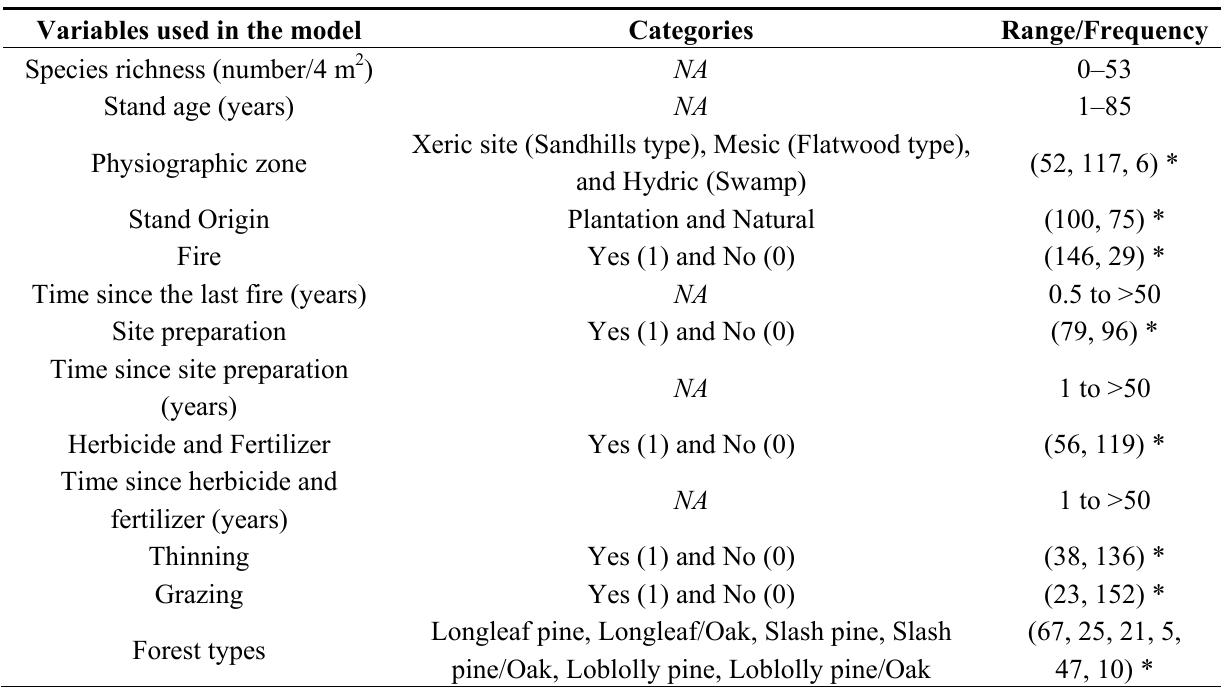
Table 2. Information collected from the literature to develop an herbaceous species richness prediction model for pine forests of the southeastern U.S. coastal